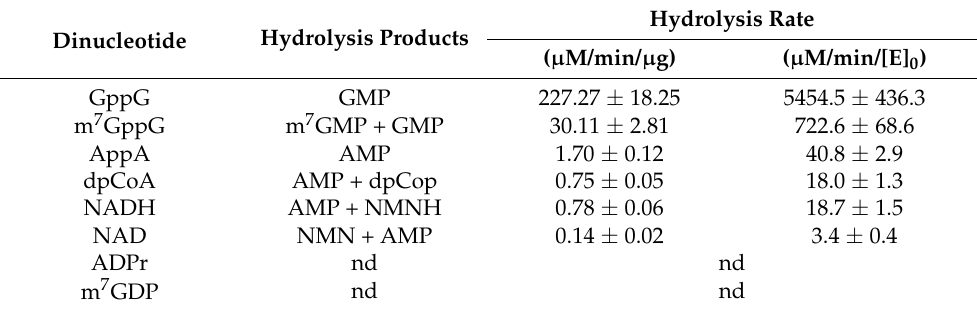
Figure 1. HPLC chromatograms for the hydrolysis of GppG catalyzed by hNudt16. ( A ) GppG in buffer (without hNudt16), ( B ) after 2 min reaction with hNudt16, ( C ) after 8 min reaction with hNudt16. Substrate concentration was 20 µM, enzyme concentration 0.002 µM. Chromatogram ( A ) was obtained after five-minute substrate incubation at 95 °C to show that heat inactivation of the enzyme in the assay buffer does not lead nonenzymatic degradation of GppG. Table 1. Hydrolysis of dinucleotides catalyzed by hNudt16; nd — hydrolysis products not detected at conditions used for dinucleotides. Data are presented as v/µg (hydrolyzed substrate (µM) per minute) per enzyme (µg) and as v/[E] 0 (hydrolyzed substrate (µM) per minute) per [enzyme] (µM).